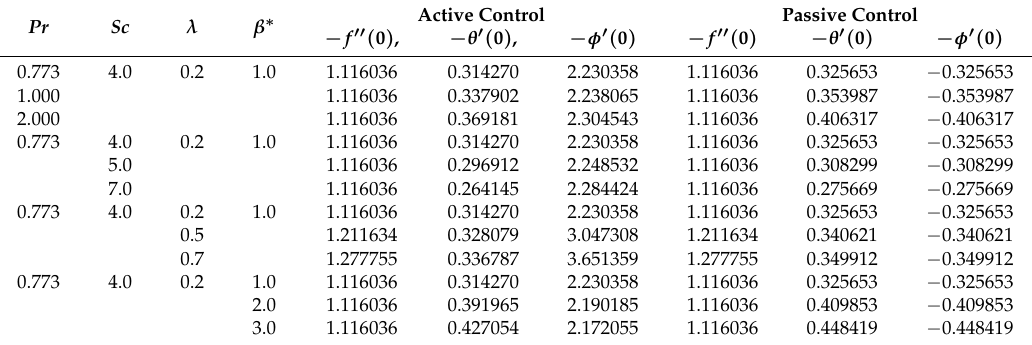
Table 6. Assessment of − f (cid:48)(cid:48) ( 0 ) , − θ (cid:48) ( 0 ) , and − φ (cid:48) ( 0 ) for numerous values of Pr and Sc ( M = 1; Nb